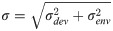
When to expect epistasis in case-control studies.(A) Distribution of effective input values among all individuals (green) in a simulated population and conditioned upon individuals being “cases” (pink) or “controls” (dark blue). Cases consist of the 1% of the population with the highest phenotype values; 500 controls are sampled from the 50% of the population whose phenotype values lie between the 25th and 75th percentiles. The area of each circle is proportional to the number of individuals whose effective input values fall within a square bin at the circle’s location. Other parameter values are zopt = s = 1; N = 5000; k = 0.01; σμ = 0.1; σdev = 0.1; σenv = 0. (B) Illustration showing how phenotype differences between cases and controls are partitioned into heritable (additive plus epistatic) and non-heritable components (see main text). zcontrols represents the phenotype of a hypothetical control whose position is given by the median of the effective input values (i.e. including developmental noise) of all actual controls. (C) Joint distribution of the epistatic fraction, Hind—hind, and fitness (relative to mean control fitness) over all cases (top 1% of phenotypes) and all sampled time points. The color of each pixel reflects the number of cases with the corresponding fitness and epistasis values. Parameter values are k = 0 and σdev = σenv = 0.05. (D) Joint distribution of epistasis and fitness of cases (top 0.5% of phenotypes) for each of three time points, t1, t2, t3, distinguished by color. Parameter values are σdev = σenv = 0.05. (E—G) Heat maps with intensity representing epistatic fraction, Hind—hind (E, G) and heritability, Hind (F) averaged over all cases with relative fitness < 0.9 and all sampled time points. In G, the y-axis indicates the total noise level σ=σdev2+​σenv2, with σdev = σenv, and σμ = 1. (H) Distribution over all sampled time points of epistasis and fitness (each averaged over all cases at the corresponding time point). Colored data points correspond to the three time points sampled in panel D. (I) Same as H but, at each sampled time point, case phenotype and case fitness were assessed immediately after an abrupt 5-fold increase in selection strength from s = 1 to s = 5. The corresponding fold change in relative fitness of each case is approximately w(s'/s)-1 (which follows from (Eq 2)), where w is the relative case fitness prior to the selection shift. See also S12 Fig. Parameter values in H and I were k = 0; σμ = 1; σdev = σenv = 0.05.